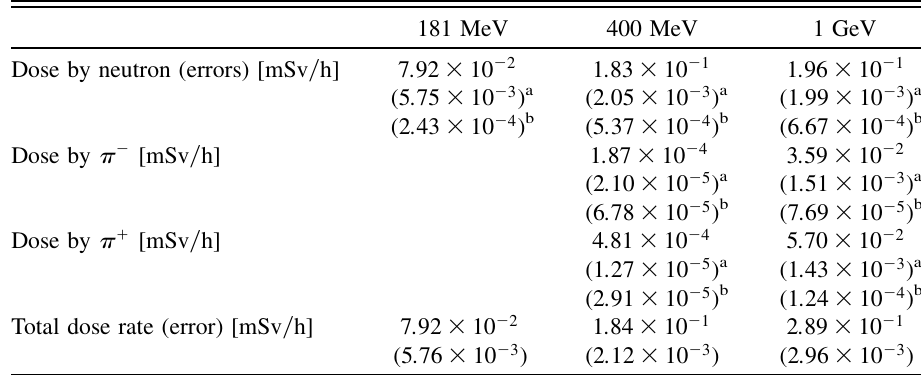
a Statistical error of the number of produced secondary particles. b Statistical error in MARS